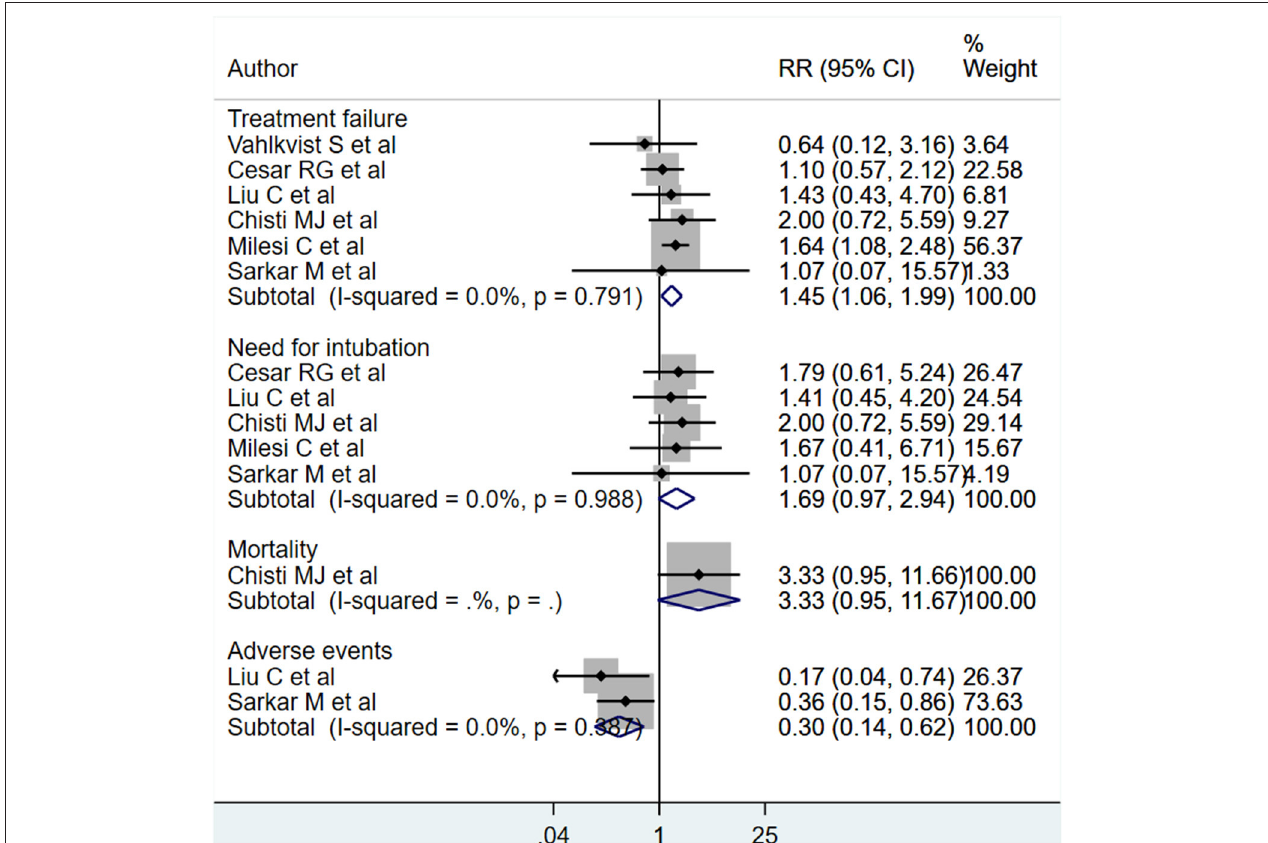
FIGURE 2 | Effects of HFNC vs. CPAP on treatment failure, need for intubation, mortality and adverse events.